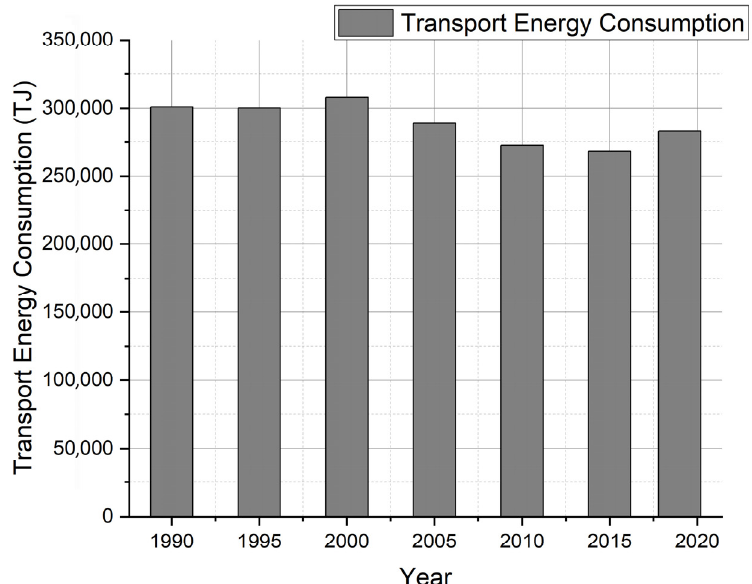
Figure 1. Energy Consumption for the transport sector in Europe.